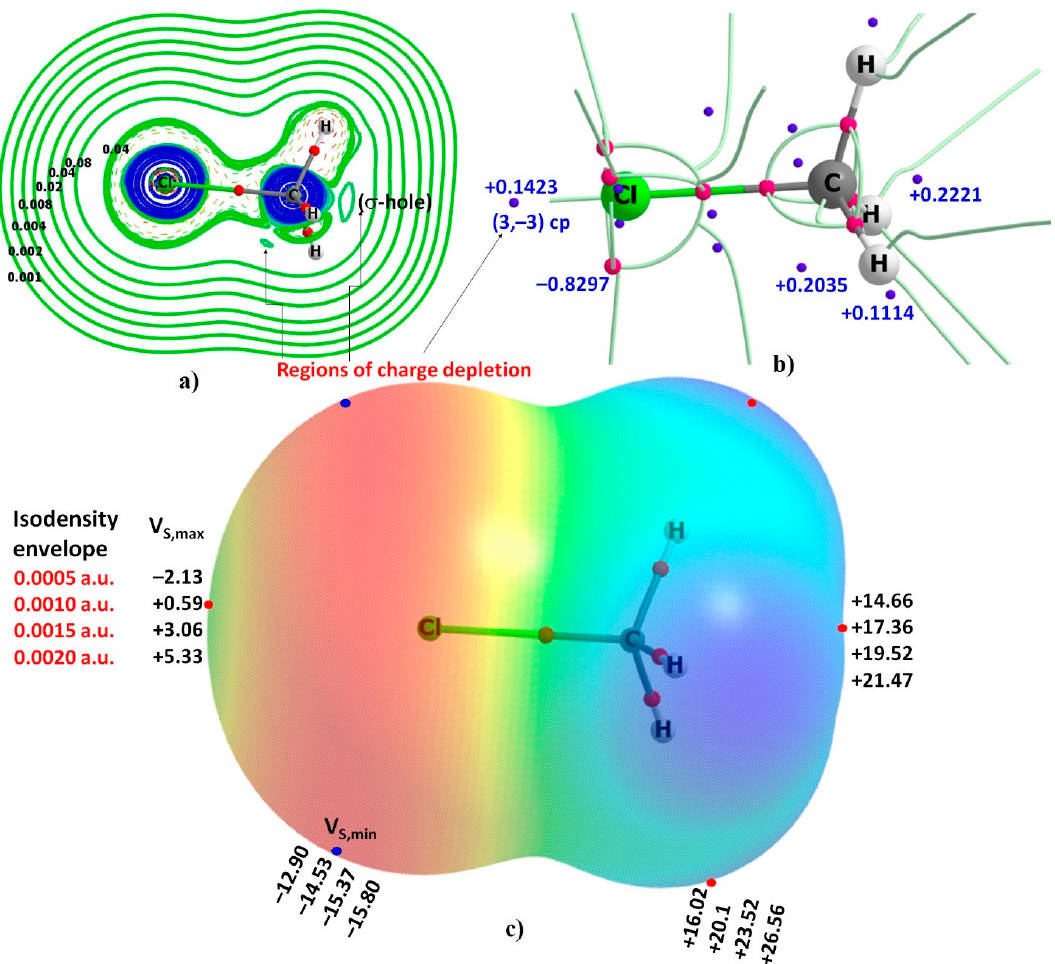
Figure 1. ( a ) The Laplacian of the charge density plot of CH 3 Cl. ( b ) Selected critical points of the Laplacian of the charge density (values in a.u.). ( c ) The 0.001 a.u. isodensity envelope mapped potential on the surface of the CH 3 Cl molecule. Values of potential extrema ( V S,min and V S,min in kcal mol − 1 ) obtained via mapping with various isodensity envelopes are also shown.